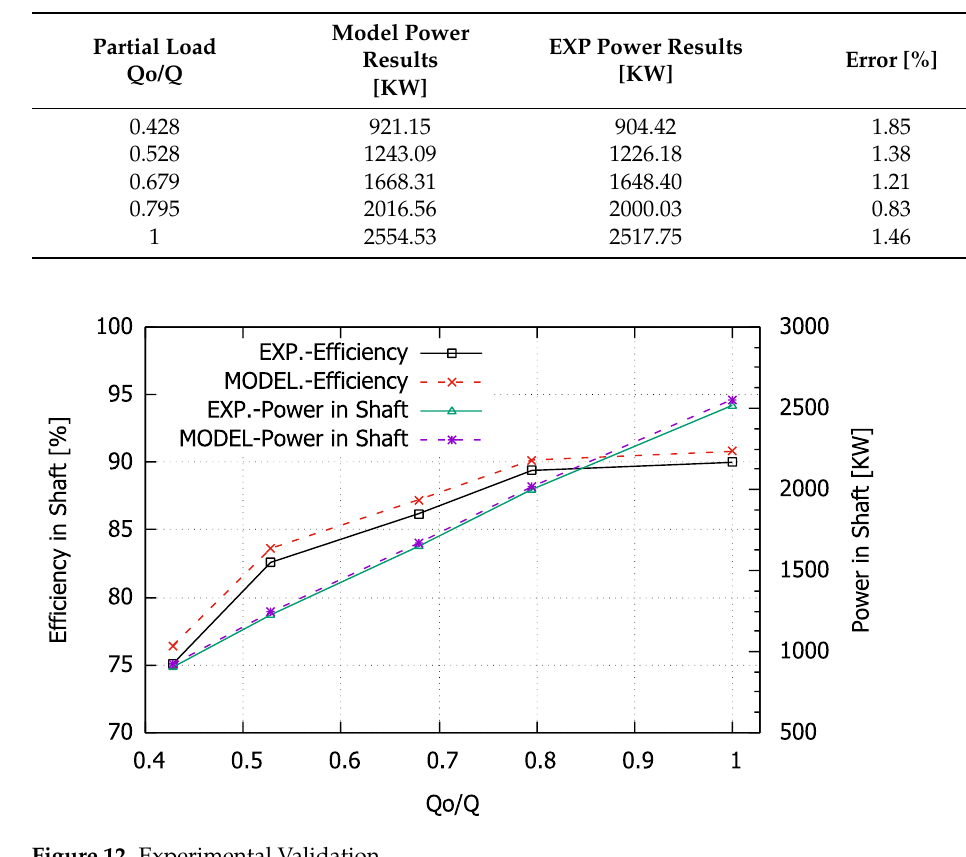
Table 7. Theorical and experimental comparison.